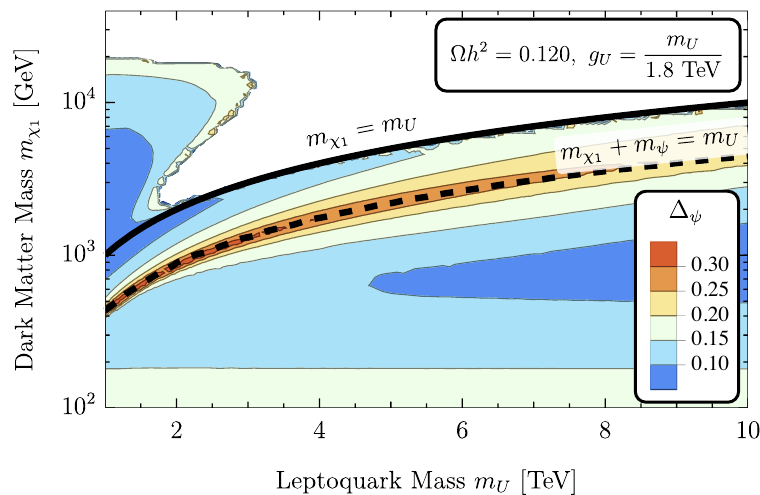
Figure 1 . The mass splitting ∆ ψ that yields the observed dark matter relic abundance as a function of the leptoquark mass m and the dark matter mass m U √ 2 in our numerics, the result is only weakly dependent on these parameters (as long m Z 0 = m U / as χ χ 2 → SM SM via an s -channel Z 0 is subdominant). Below the solid black line m χ 1 while the dotted black line shows the resonant region where m matter relic abundance cannot be obtained in the white